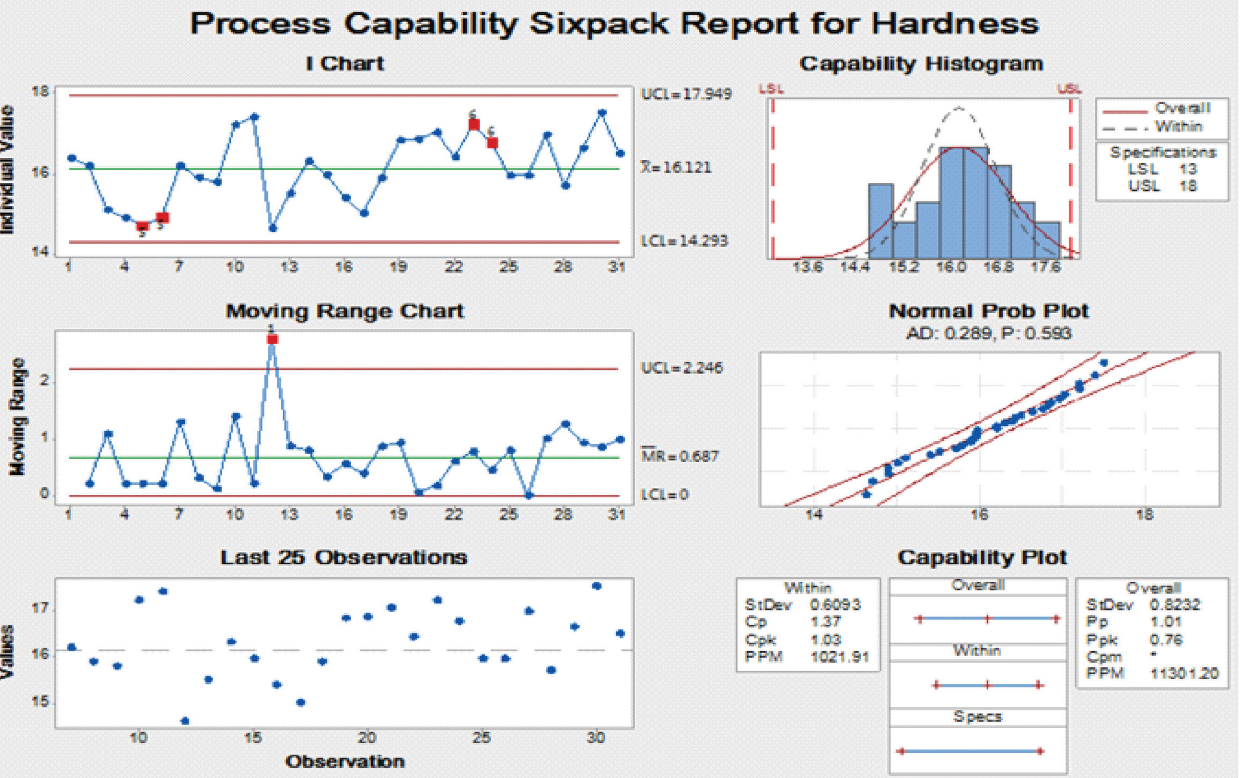
FIGURE 3 - Statistical control monitoring of hardness test showing out-of-control points as red